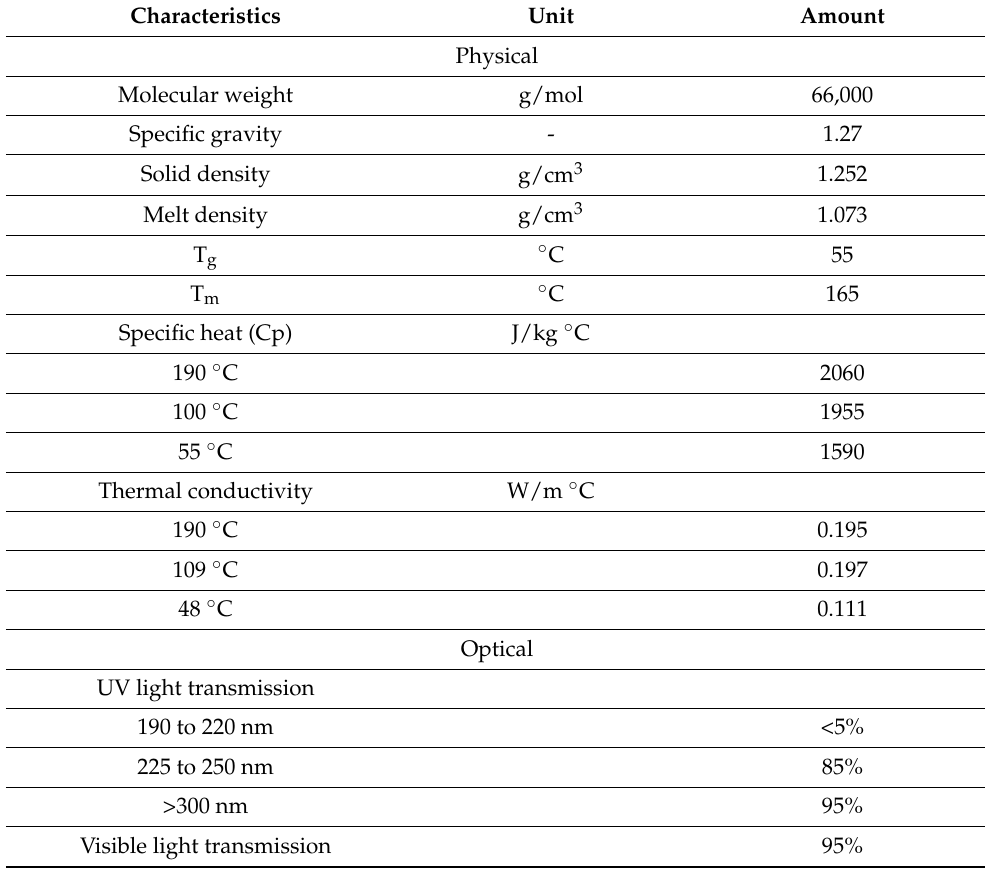
Table 3. General physical and optical properties of commercial amorphous PLA [82,96–98].